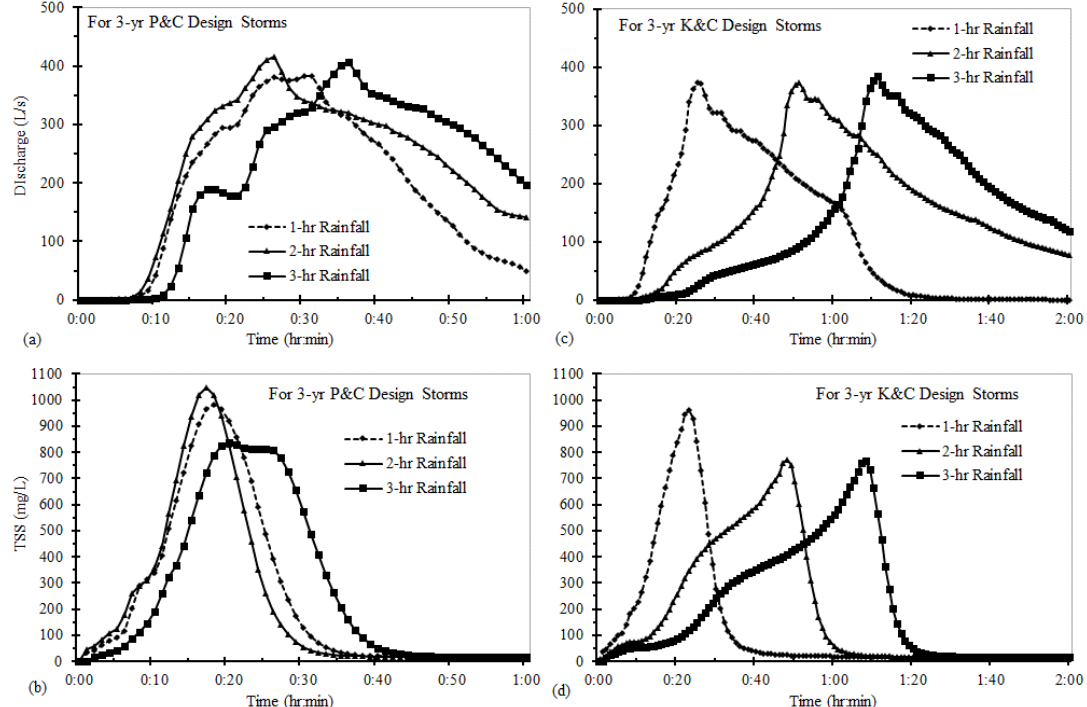
Figure 11. Simulated discharge (L/S) and TSS concentration (mg/L) at the catchment outlet under three-year design rainfall distributed using the P&C method ( a , b ) and K&C method ( c , d ) for three rainfall durations (1, 2 and 3 h).